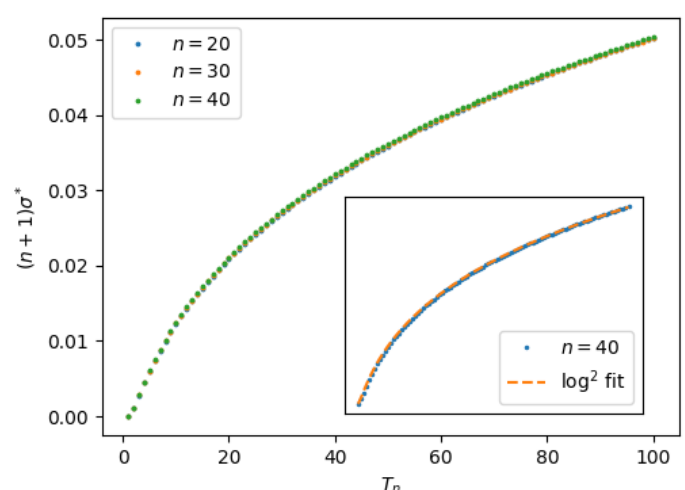
Figure 4: In the overdamped case γ = 100, for chains of n = 20,30,40 oscillators, n + 1 times the minimum EPR σ ∗ as a function of the temperature of the right-most = 1. The three data sets overlap and oscillator ranging from 1 to 100, for given T 0 are fitted by a squared-log curve as in Eq. (6) (see example for n = 40 in the